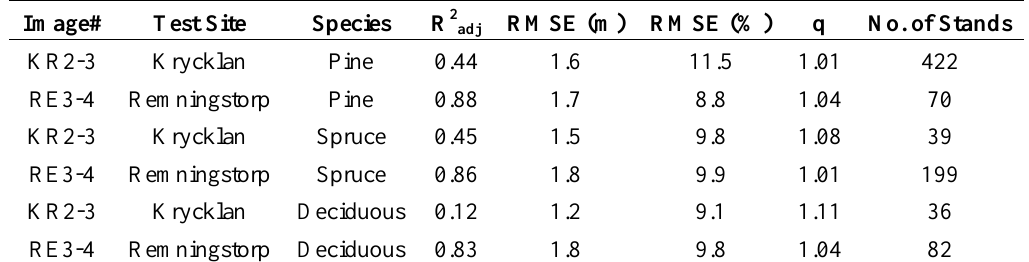
Table 8. Species-specific results of H for the image pairs KR2-3 and RE3-4.